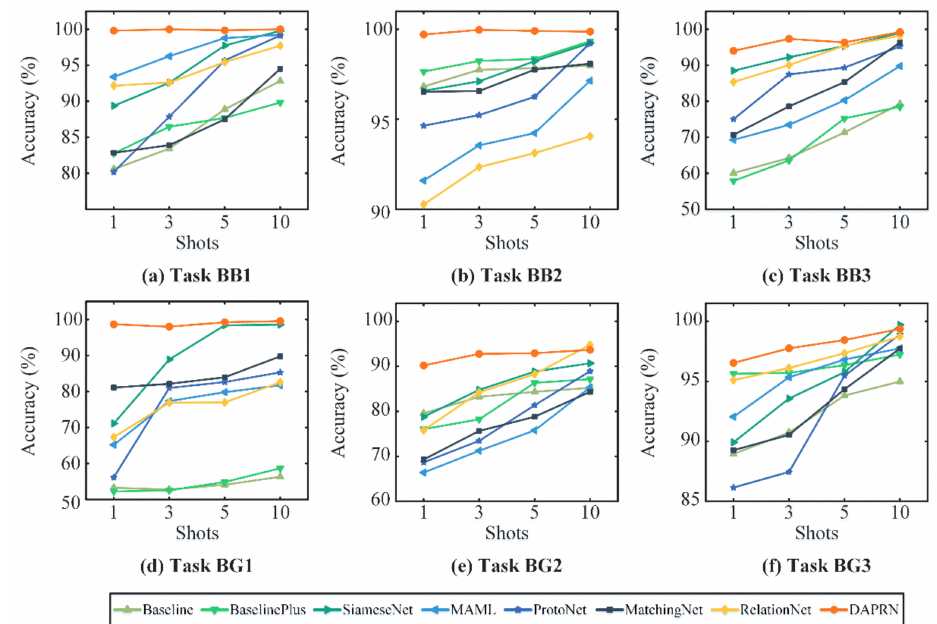
Figure 9. The test accuracy of different shots using all few-shot